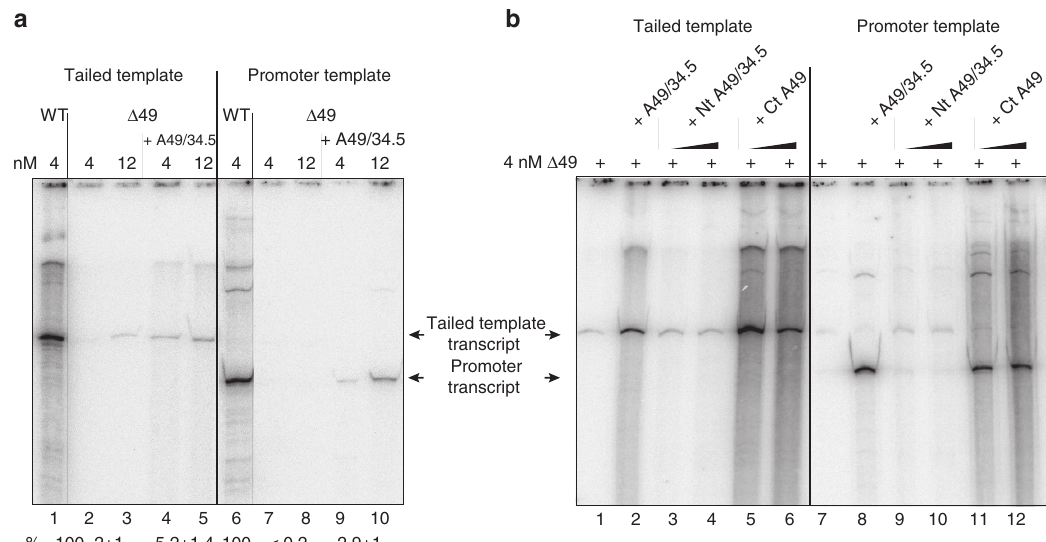
Figure 6 | The A49/34.5 dimer and the C-terminal part of subunit A49 are required for transcription initiation and support non-specific transcription. ( a ) Recombinant subunit A49/34.5 can complement for the transcription defect of Pol I D A49. Tailed template assays and promoter specific transcription were performed using 4 or 12nM WT Pol I or D A49 Pol I in the presence and absence of purified recombinant A49/34.5 heterodimer. Promoter-dependent assays were performed in the presence of 70nM Rrn3 and 20nM CF. Note that radiolabelled transcripts can be clearly seen in tailed template transcription using Pol I D A49 after longer exposure, whereas no transcripts can be detected in promoter-dependent assays. ( b ) The C-terminus of A49 is sufficient to complement for initiation in a minimal transcription system which is dependent on recombinant CF, Rrn3 and purified Pol I D A49. Same experimental outline as in a , but transcription was analysed in the presence of the purified C-terminal domain of A49 (residues 111–426) or the coexpressed N-terminal domain of A49 (1–181) and A34.5 (Materials and methods